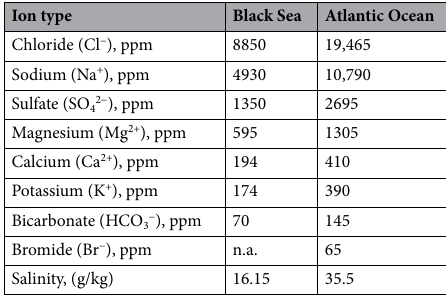
Table 1. Major ion composition of marine